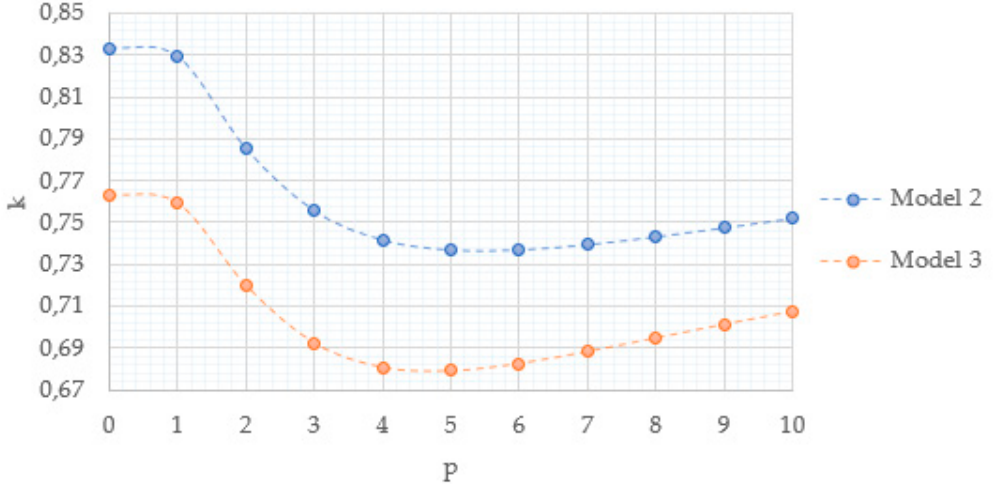
Figure 11. Porosity distribution models M2 and M3: evolution of neutral surface shift.